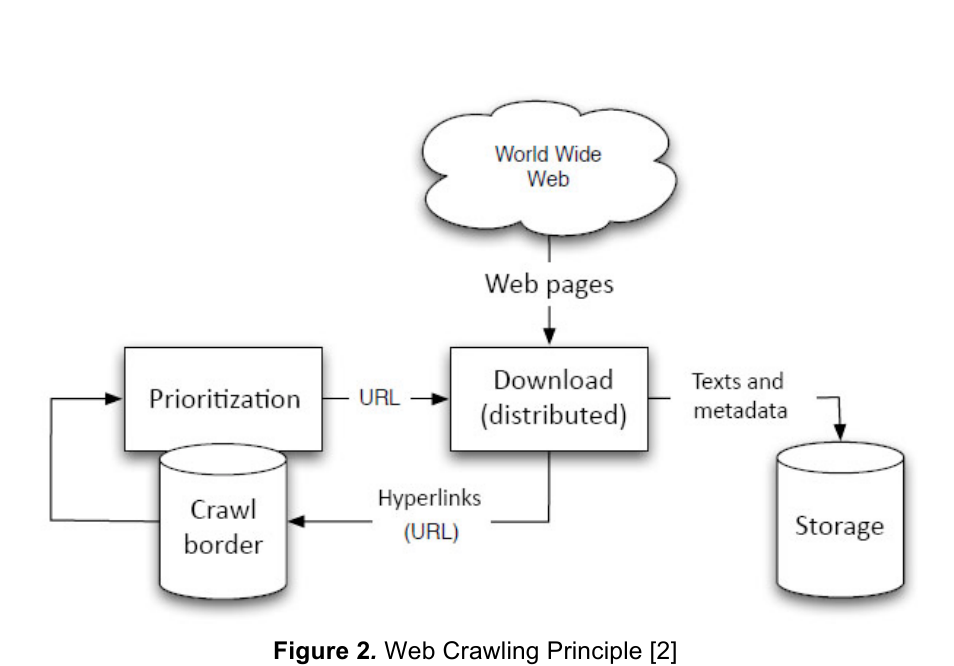
Figure 2 . Web Crawling Principle